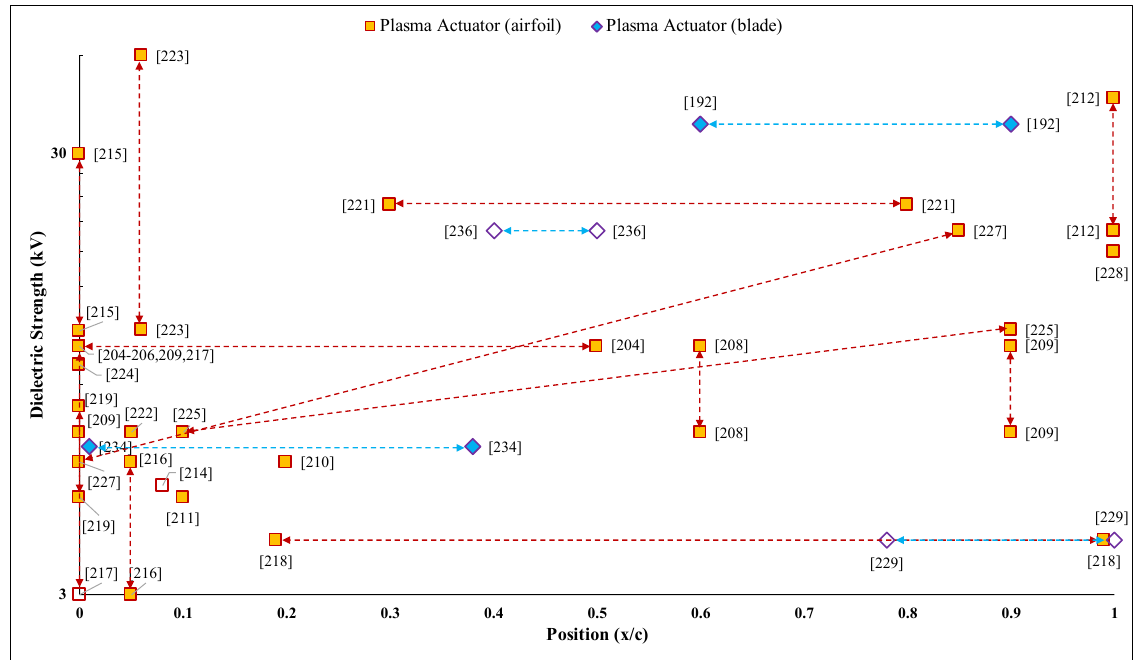
Figure 9. Literature survey of plasma actuators. (The empty and filled markers correspond to the numerical and experimen- tal investigations, respectively. The arrows correspond to the range of